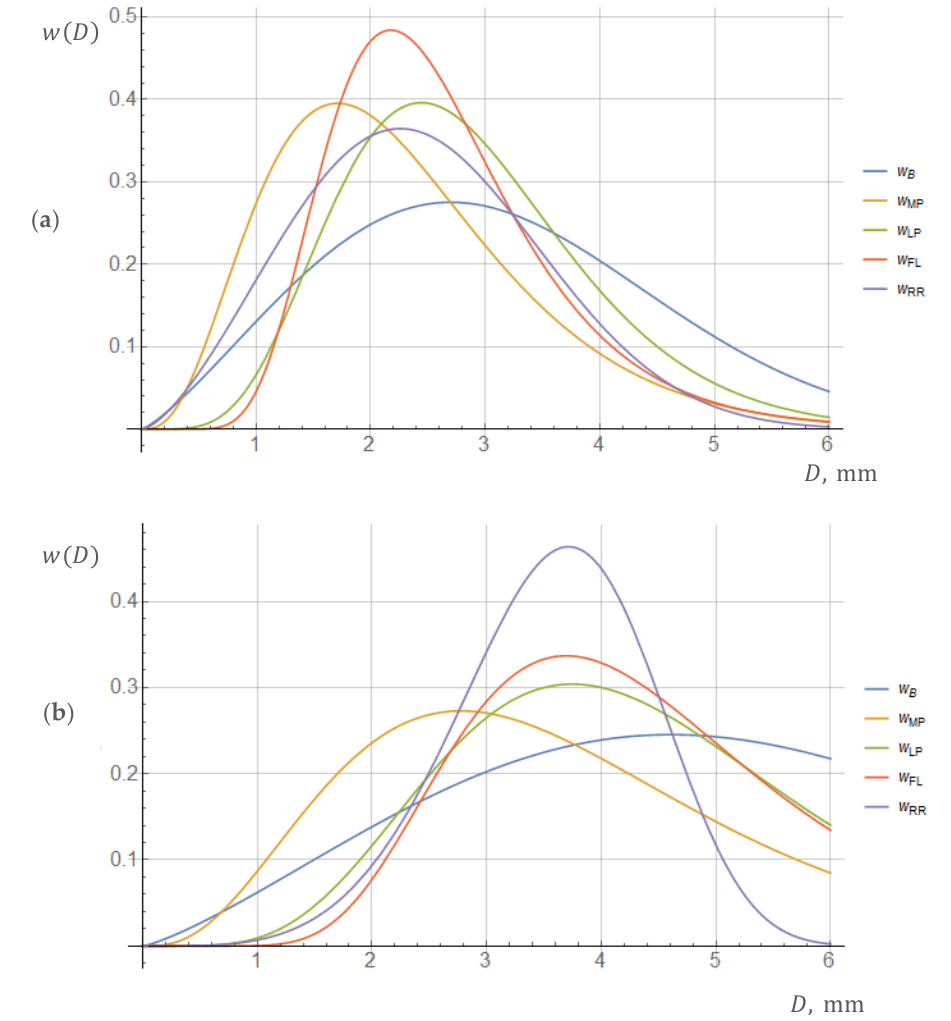
Figure 3. Density of mass distribution over droplet diameter for different intensities R : ( a ) 72 mm/h; ( b ) 720 mm/h.